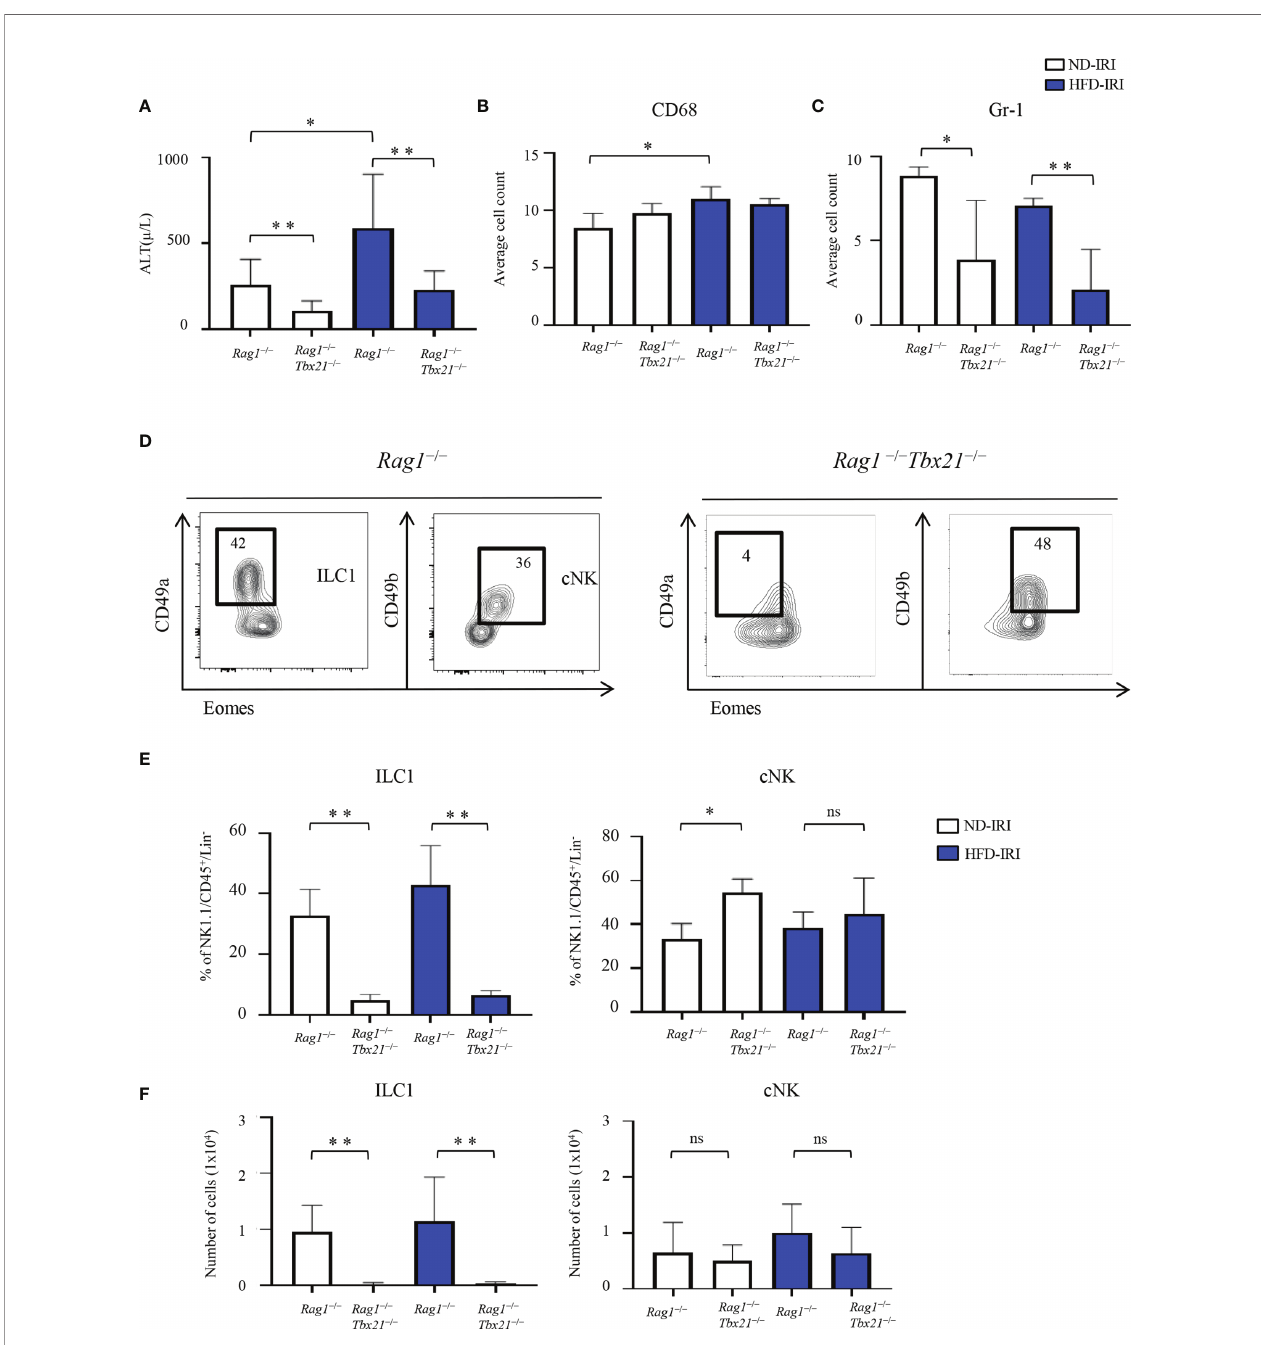
FIGURE 3 | Absence of ILCs lead to increased liver protection to IRI. HFD was started at fi ve-to-seven weeks of age and maintained for 12 weeks. All mice were 17-19 weeks at time of evaluation. A 45-minute partial warm ischemia time was used for IRI experiments. All analysis was performed following 24 hours of reperfusion. (A) Serum alanine aminotransferase (ALT) was measured in ND-IRI and HFD-IRI between Rag1 − / − and Rag1-Tbet DKO mice (n=5-7). The numbers of CD68 + (B) and Gr1 + (C) in the ND-IRI and HFD-IRI mice were quanti fi ed (n=9-10). (D) Representative fl ow plots show that the frequencies of ILC1s were nearly absent in Rag1-Tbet DKO. Data in Figure (D) are representative of ND IRI Rag1 − / − or Rag1-Tbet DKO mice. (E) Percentage (F) and the absolute number of ILC1s and cNKs in Rag1 − / − or Rag1- Tbet DKO mice following ND-IRI and HFD-IRI (n=5-7). Signi fi cance was determined using Mann Whitney Test. *p<0.05; **p<0.01; ns; not signi fi